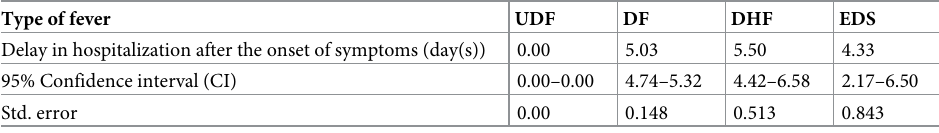
Table 3. Delay in hospitalization after the onset of symptoms and the type of dengue fever. Delay in hospitalization after the onset of symptoms (day(s))